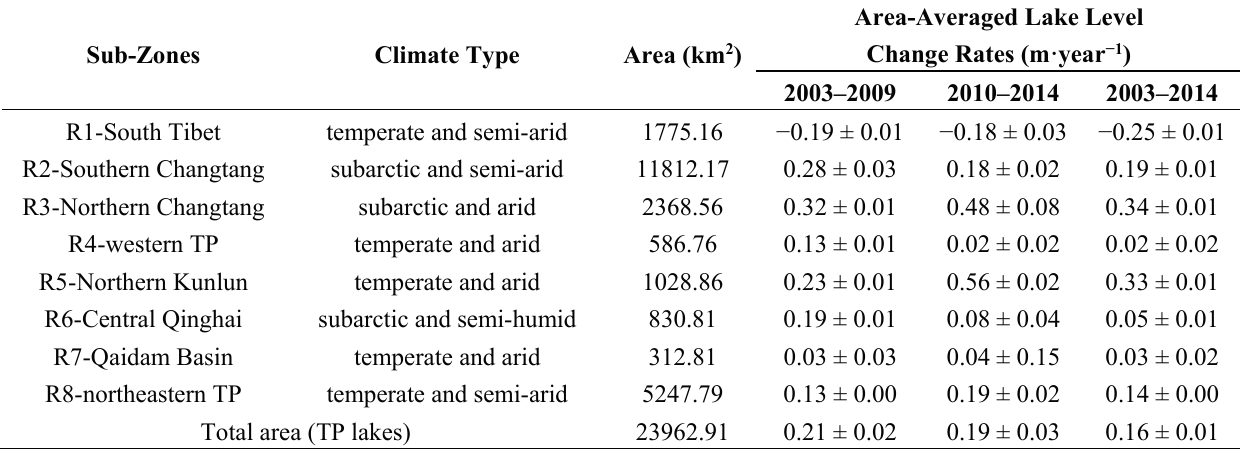
Table 2. Comparison on change rates of lake level in different climate sub-zones